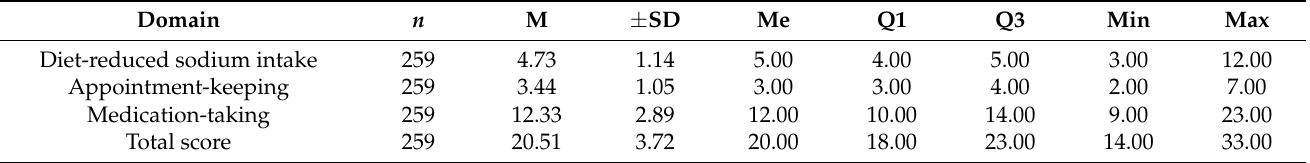
Table 4. Assessment of three behavioral domains by the Hill–Bone Compliance to High Blood Pressure Therapy Scale in HBP patients.